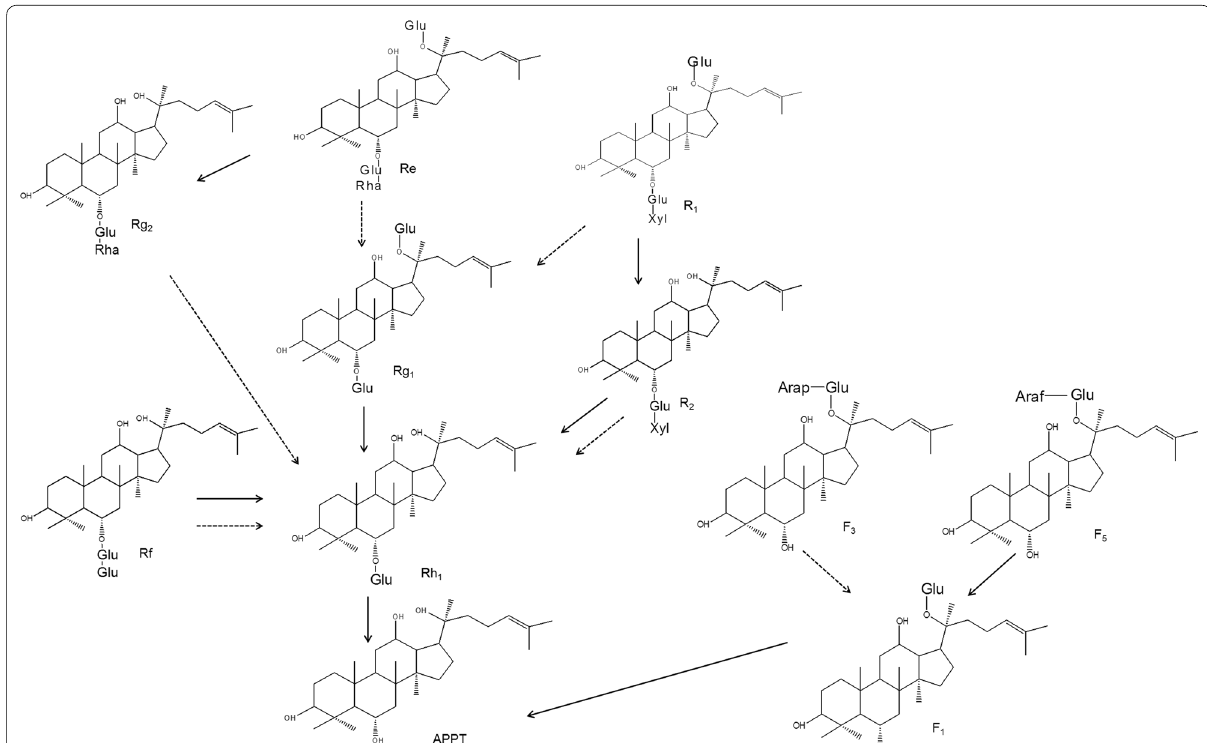
Fig. 2 Hydrolytic pathways of glycosylated protopanaxatriol (PPT) ginsenosides to aglycon protopanaxatriol (APPT) catalyzed by β‑glycosidases from D. turgidum (DT‑bgl) and P. furiosus (PF‑bgl). Solid and dotted lines represent DT‑bgl and PF‑bgl,